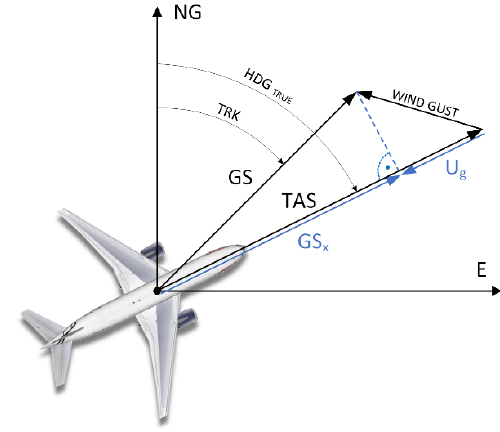
Figure 1. Illustration of relations from Equation (1).